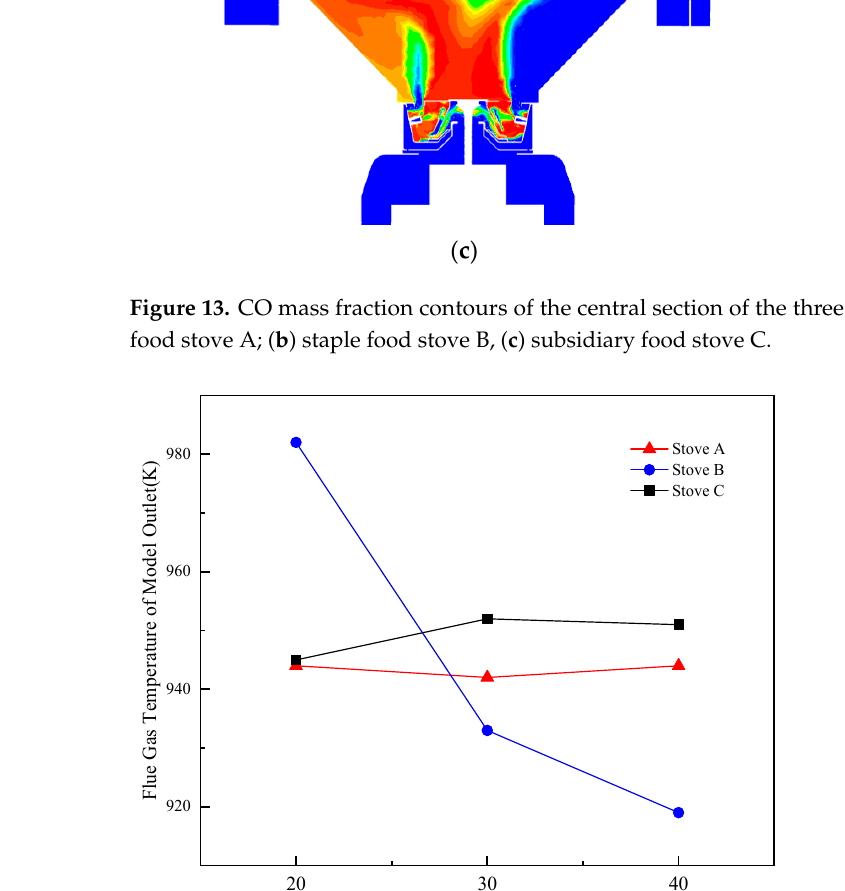
Figure 14. Flue gas temperature of the model outlet of the three stoves at different power rates.